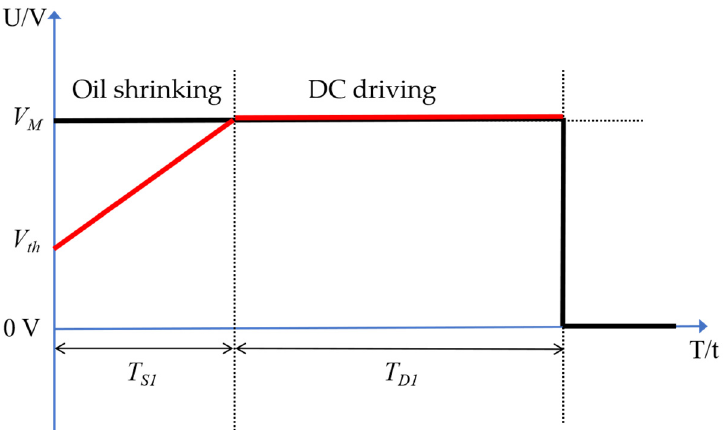
Figure 10. A schematic diagram of two conventional driving waveforms for EWDs. Both of them are composed of an oil shrinking stage and a DC driving stage. T S 1 and T D 1 are the durations of the oil shrinking stage and the DC driving stage.